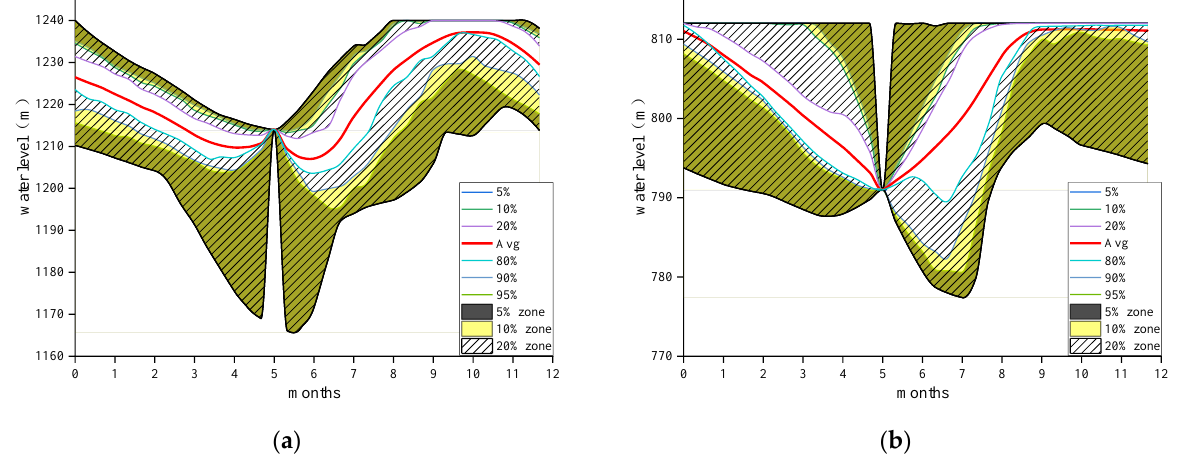
Figure 6. The distribution of the water level over space and time within a year. ( a ) OY07; ( b ) OY10.